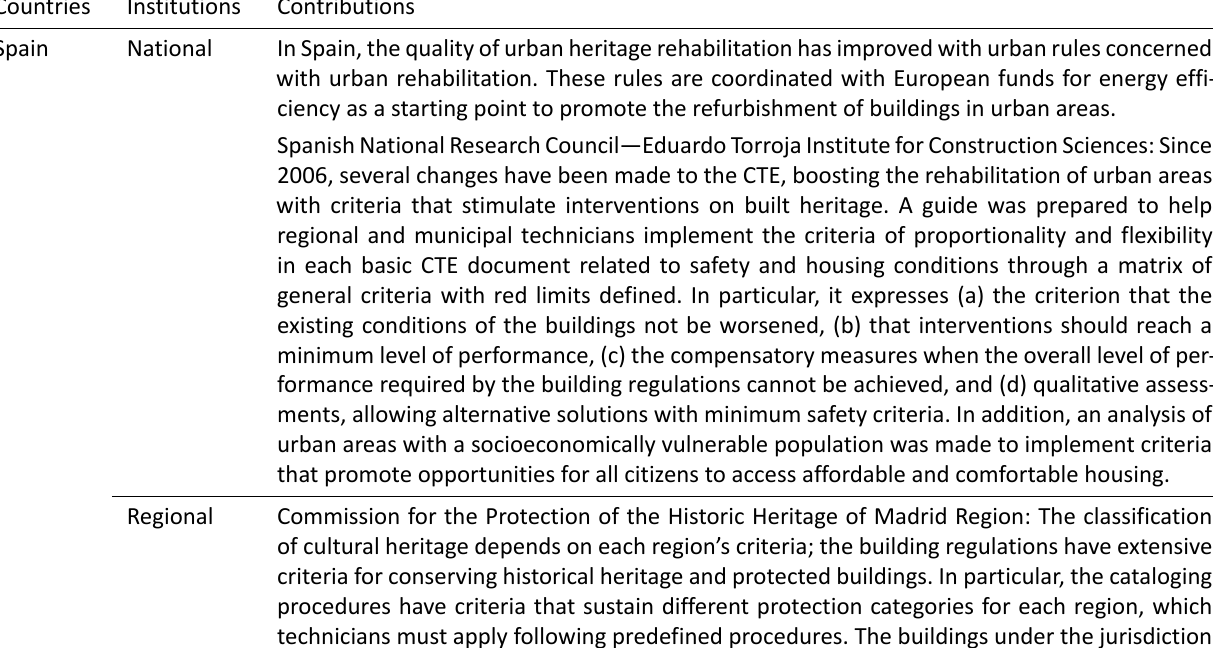
Table 3. (Cont.) Institutional stakeholders’ contributions to building regulations concerning urban rehabilitation.